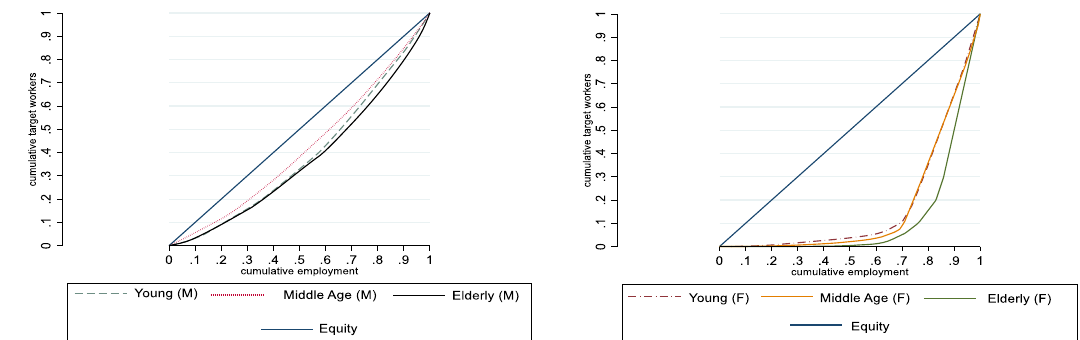
Fig. 3 Occupational segregation by gender and age. The fi gure shows the occupational segregation of male and female workers with respect to different age groups. Table 6 Occupational gender segregation by age. Local segregation